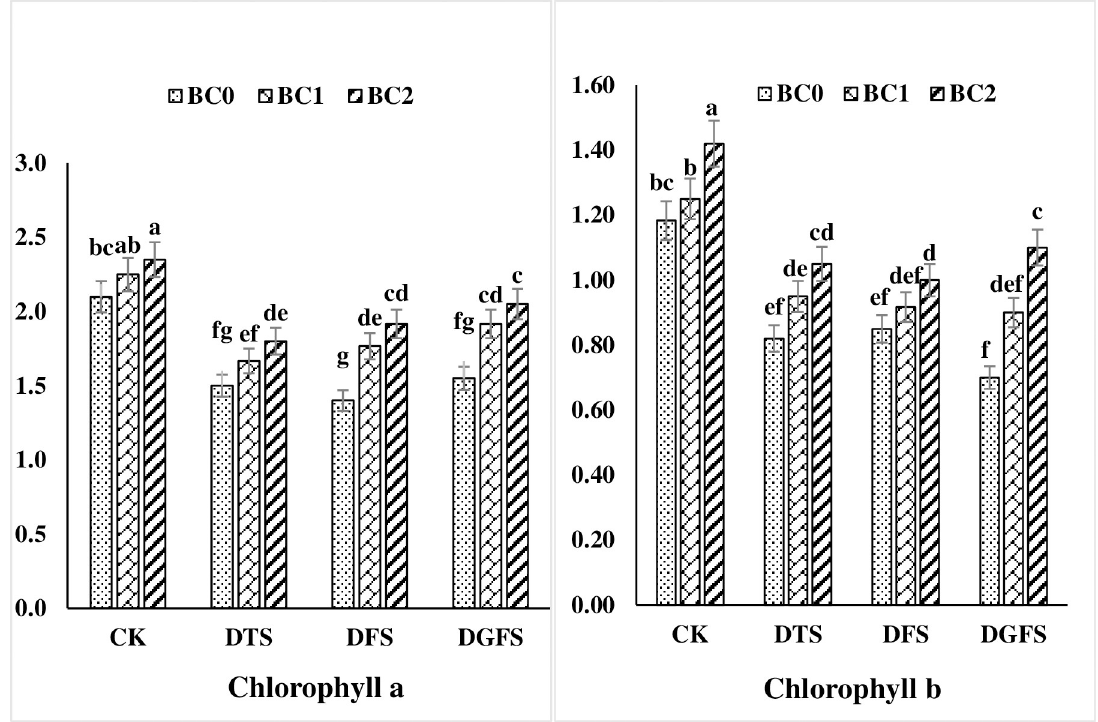
Fig 2. Chlorophyll a and b (mg g -1 FW) contents affected by biochar application under drought stress at critical growth stages of wheat. CK, DTS, DFS and DGFS indicates control, drought at tillering, flowering and grain filling stages respectively. BC 0 , BC 1 and BC 2 indicates control, 3% and 5% biochar respectively. Error bars indicates standard error (n =